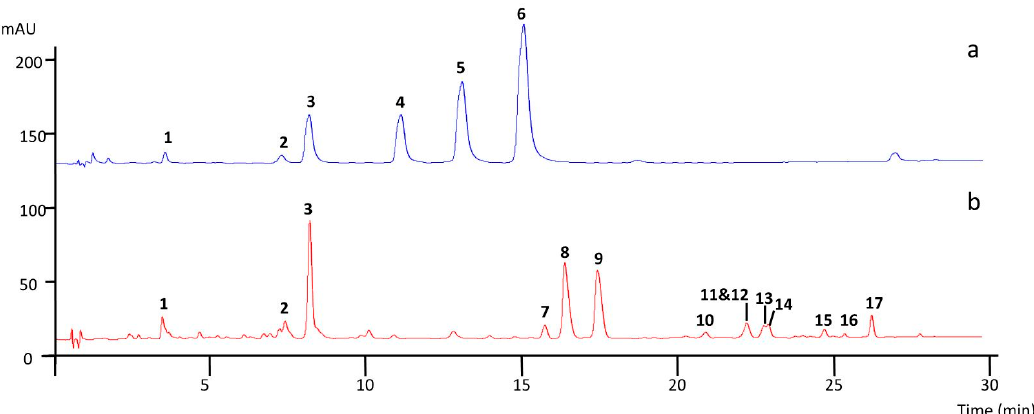
Figure 2. Representative chromatograms of: ( a ) root extracts; and ( b ) leaflet extracts of Euterpe oleracea at λ = 320 nm; Kinetex PFP column 100 × 4.6 mm, 2.6 µm; ( 1 ) 3-CQA; ( 2 ) 4-CQA; ( 3 ) 5-CQA; ( 4 ) 4-CSA; ( 5 ) 5-CSA; ( 6 ) CSA; ( 7 ) 6,8-di- C -hexosyl apigenin; ( 8 , 9 ) 6,8-di- C -hexosyl apigenin sulfate; ( 10 , 14 , 15 ) 6- C -hexosyl-8- C -pentosyl apigenin isomers; ( 12 , 16 ) 6- C -pentosyl-8- C -hexosyl apigenin isomer; ( 11 ) 8- C - glucosyl luteolin; ( 13 ) 6- C -glucosyl luteolin; and ( 17 ) 6- C -glucosyl apigenin; CQA: caffeoylquinic acid; CSA: caffeoylshikimic acid.